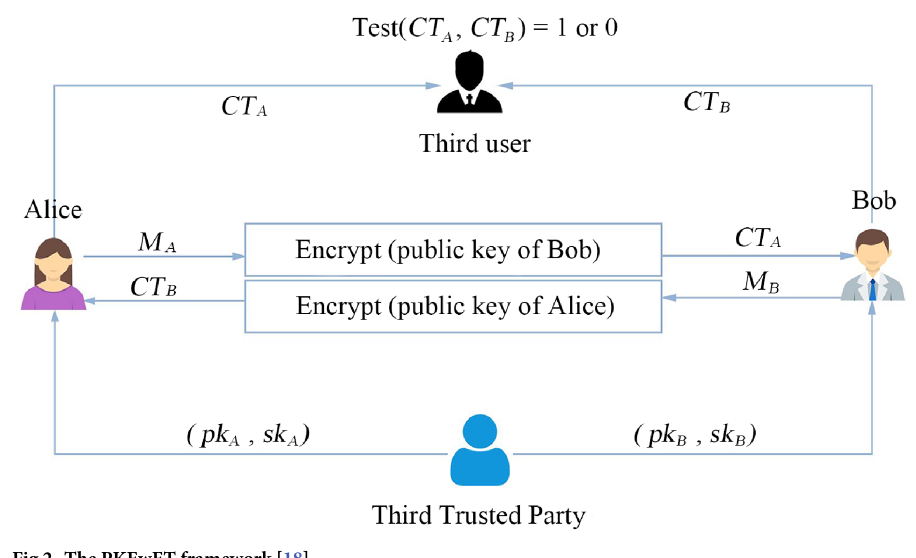
Fig 2. The PKEwET framework [18].